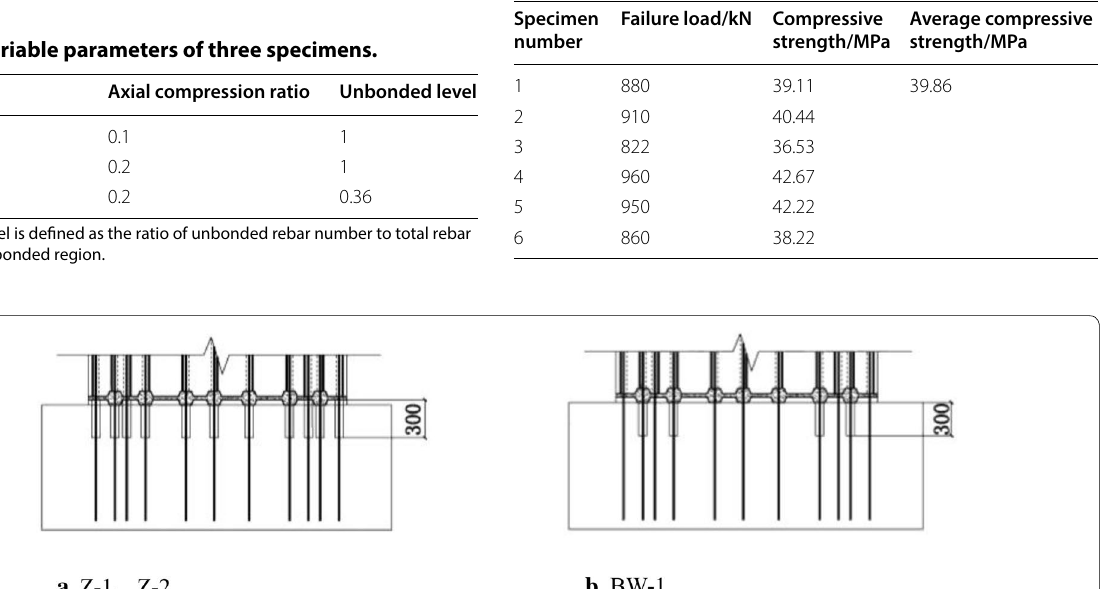
Table 2 Mechanical property of